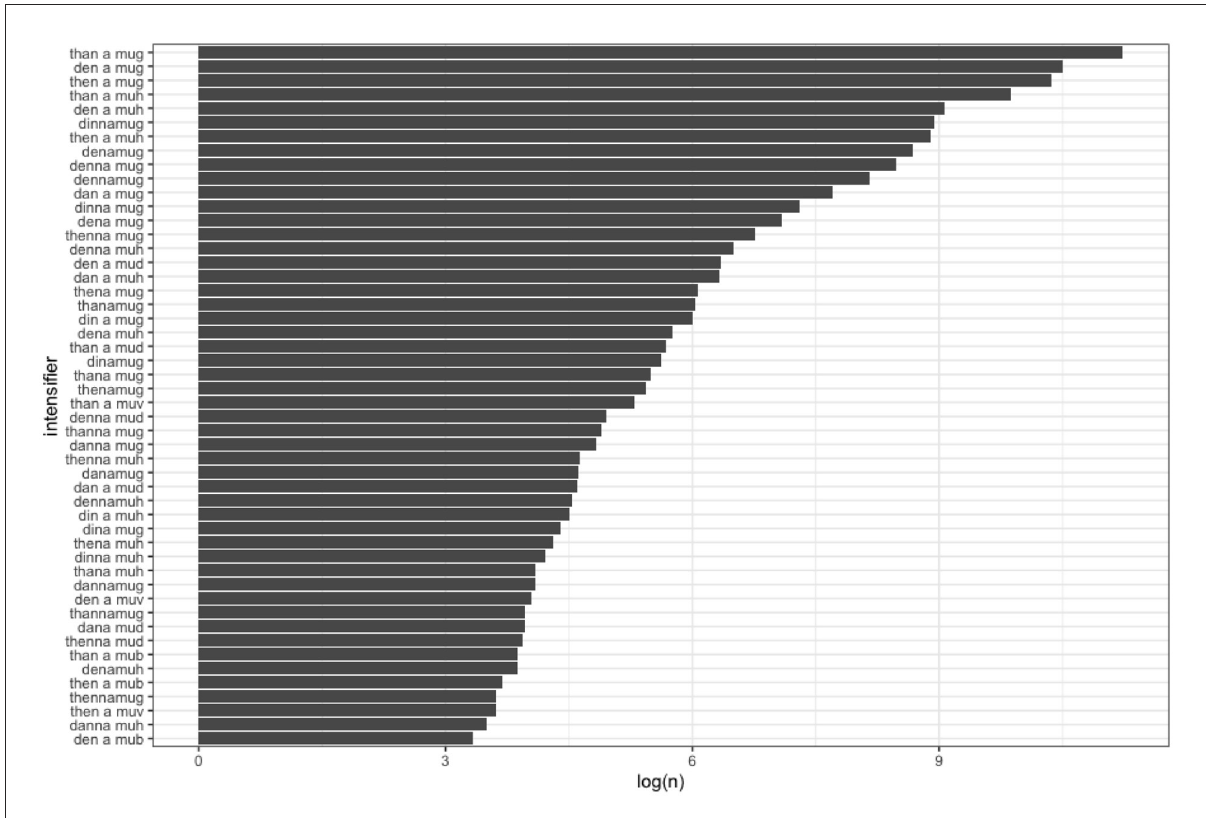
FIGURE3 Fifty most common intensifiers (log